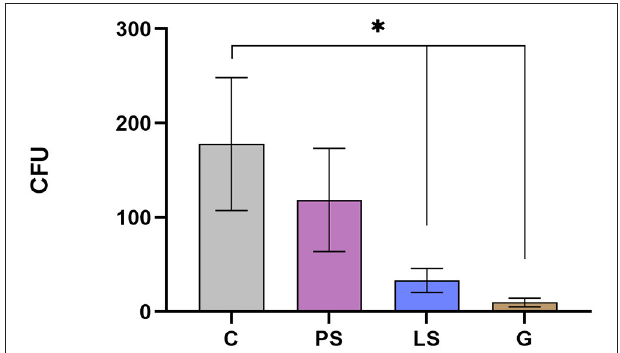
FIGURE 3 | Total viable aerobic bacterial (colony-forming units) in the four experimental groups: Control (C), without antibiotics; Penicillin-Streptomycin (PS); (500 UI) − 625 µ g/mL, respectively; Lincomycin-Spectinomycin (LS) 300–600 µ g/mL, respectively; and Gentamicin (G) 1,000 µ g/mL. Eight males were analyzed (1 ejaculate per male) including the same males in each experimental group. Significant differences ( P < 0.05) are represented with an asterisk between the antibiotic treatment and the Control sample without